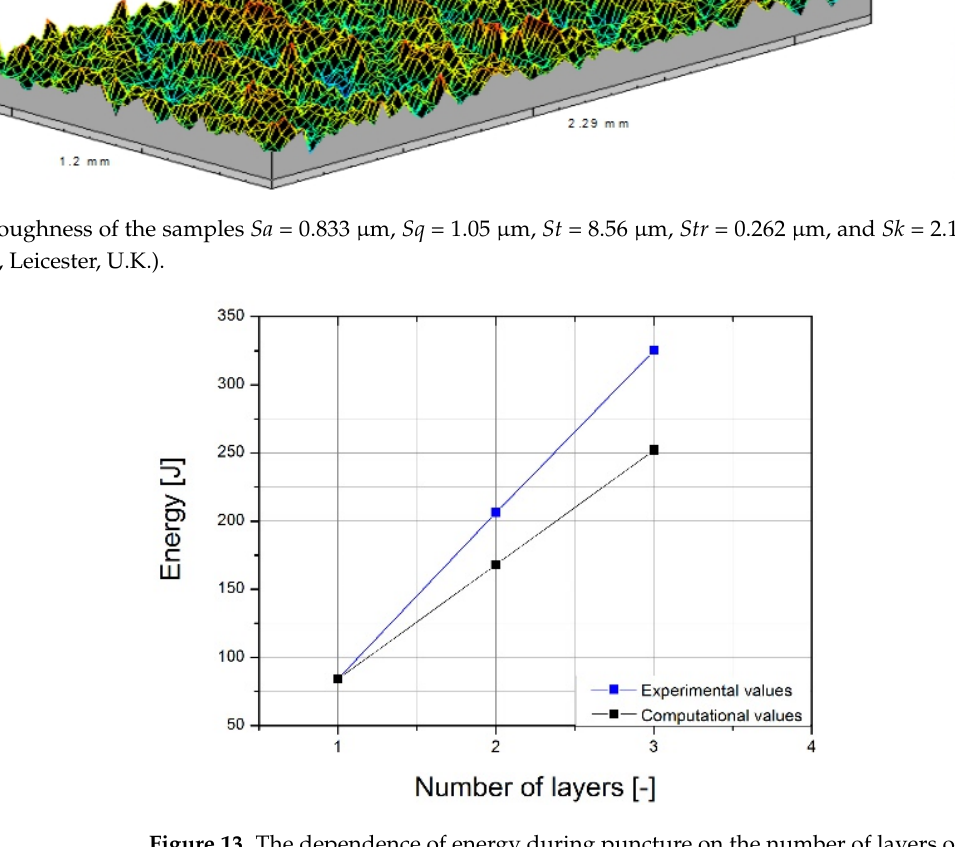
( b3 ) Figure 14. Results of dynamic impact tests of 1 mm Ti6Al4V sheet: ( a1 – a3 ) view from above; ( b1 – b3 ) view from bottom.